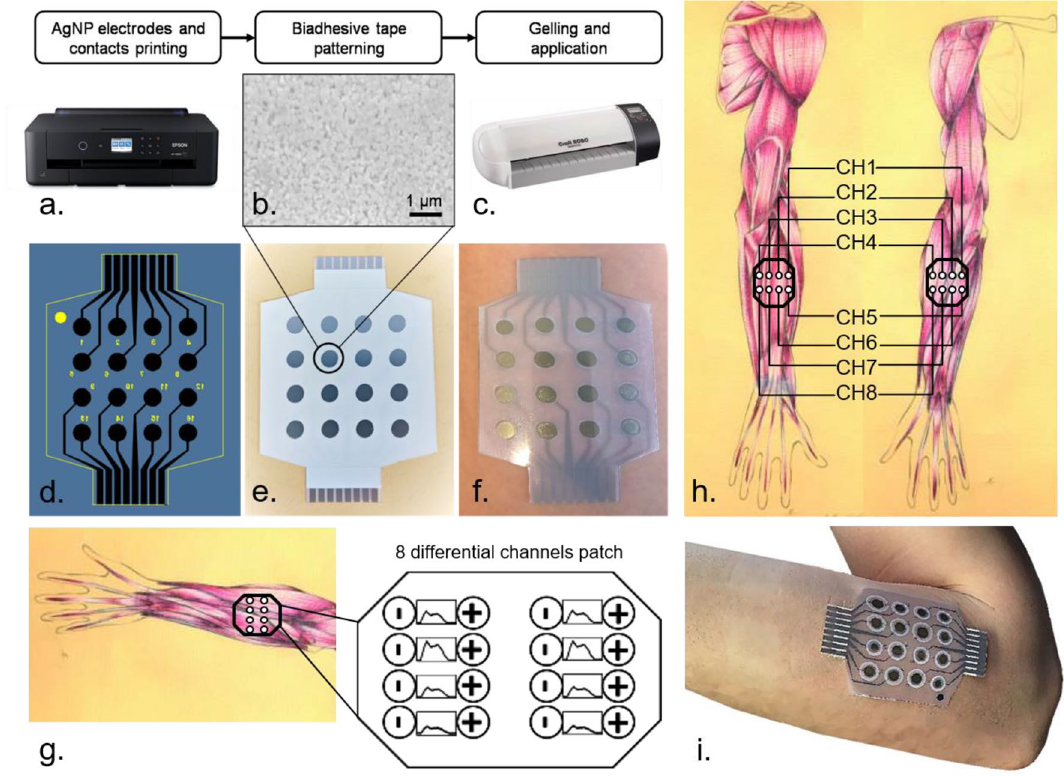
Figure 5. Graphical representation of the fabrication process of the electrodes’ matrix and their positioning on the forearm. ( a ) The Epson Stylus 1500 W consumer printer used for the printed sensors, loaded with AgNP and standard black ink. ( b ) SEM image of the printed AgNPs. ( c ) CraftROBO C330 digital blade cutter for the patterning of the biadhesive sheet. ( d ) AutoCAD matrix design with cutting lines and mirrored text to identify the electrodes through the transparent PET film after its application on the skin. ( e ) Printed electrodes’ matrix with the biadhesive passivating layer sticked on top. ( f ) Matrix of electrodes gelled and ready to be positioned on the participant forearm. ( g ) Example of the matrix positioning for extension tasks and of the readout of the signals between the electrodes, forming the 8 channels (arm original drawings courtesy of Maria Catalina Li Puma). ( h ) Readout channels positions for extension (right) and flexion (left), (arm original drawings courtesy of Maria Catalina Li Puma). ( i ) Matrix positioned on the forearm of one of the subjects. Figure created with Microsoft PowerPoint